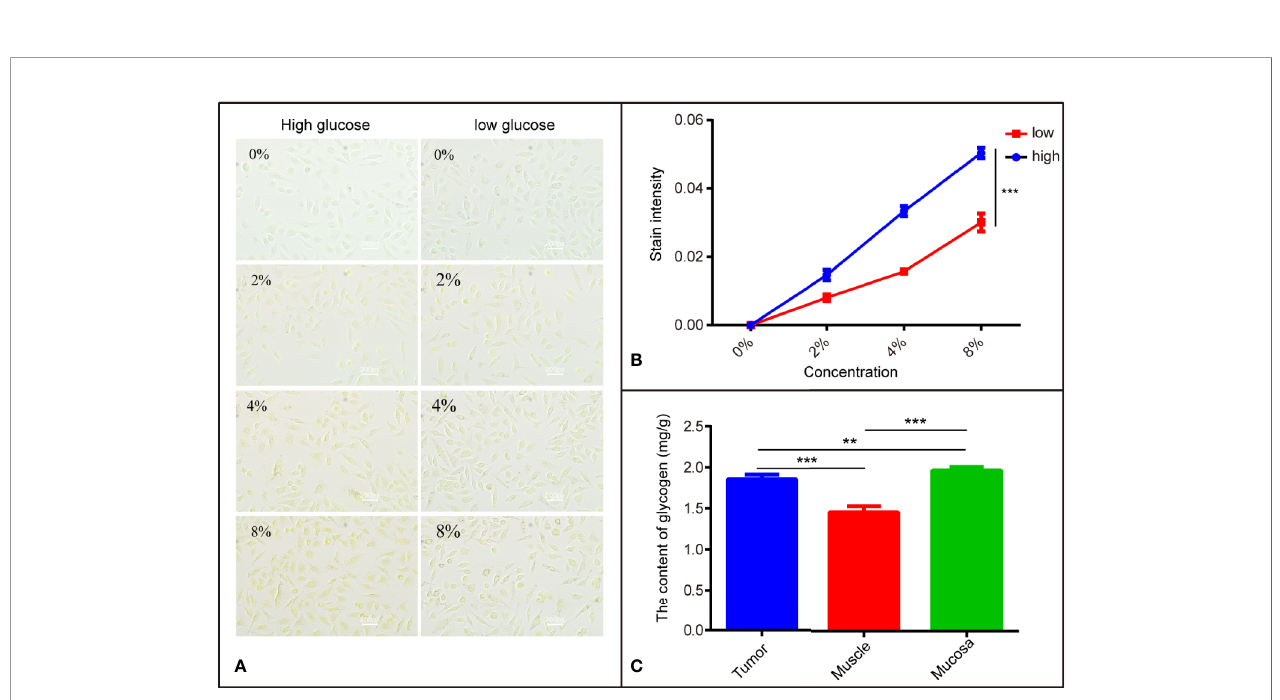
FIGURE 4 | The different af fi nity of I 2 -IK with different tissues is related to glycogen. (A) The stained image of SCC9 cells with different concentrations of I 2 -IK. (B) Quantitative result of cells stained with I 2 -IK. (C) The content of glycogen in different tissues including tumor tissues, muscle, and mucosa. ** P < 0.01, *** P < 0.001.